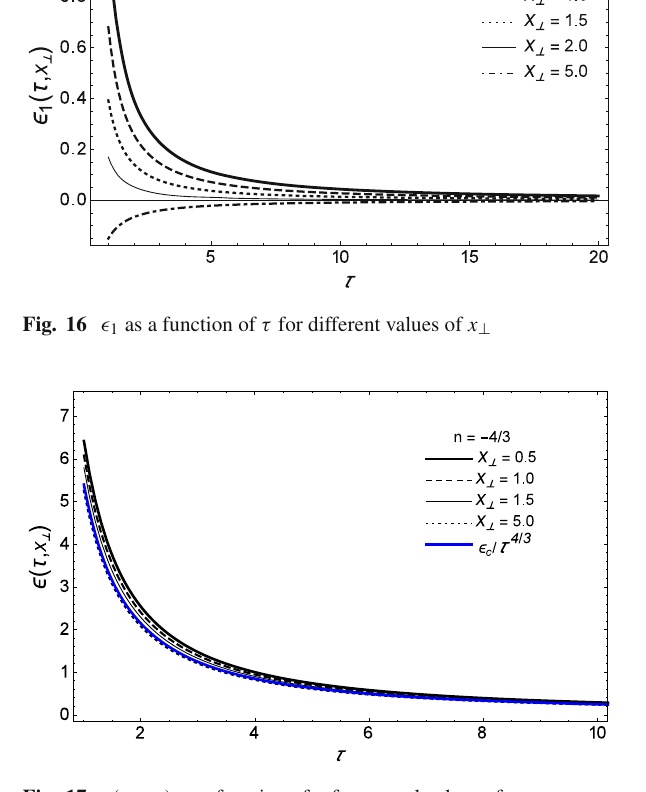
Fig. 17 (cid:5)(τ, x ⊥ ) as a function of τ for several values of x ⊥